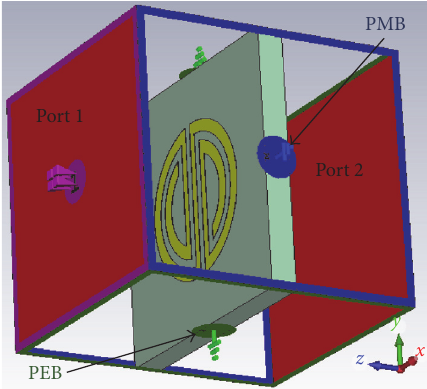
Figure 2: The boundary conditions of the proposed unit cell used in the